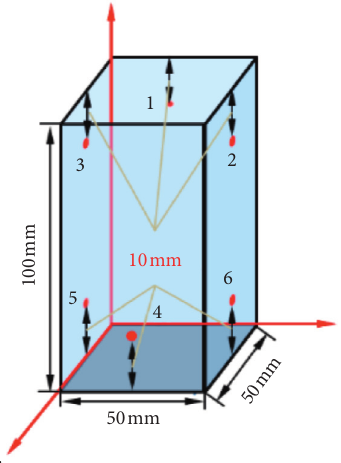
Figure 6: AE sensor spatial